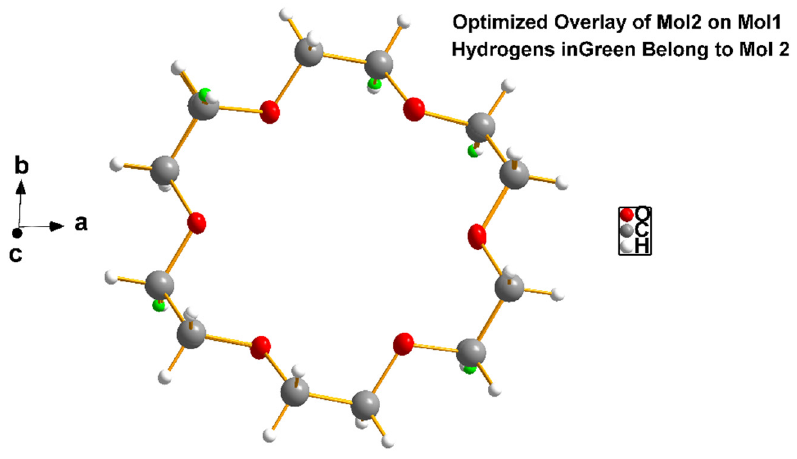
Figure 9. It is nearly impossible to tell that there are two ether molecules here superposed on one another, except for the fact that five of the hydrogens differ enough to be discernibly different, as emphasized by the green–white pairs shown above. The idealized geometry of these ether rings is D 3d .